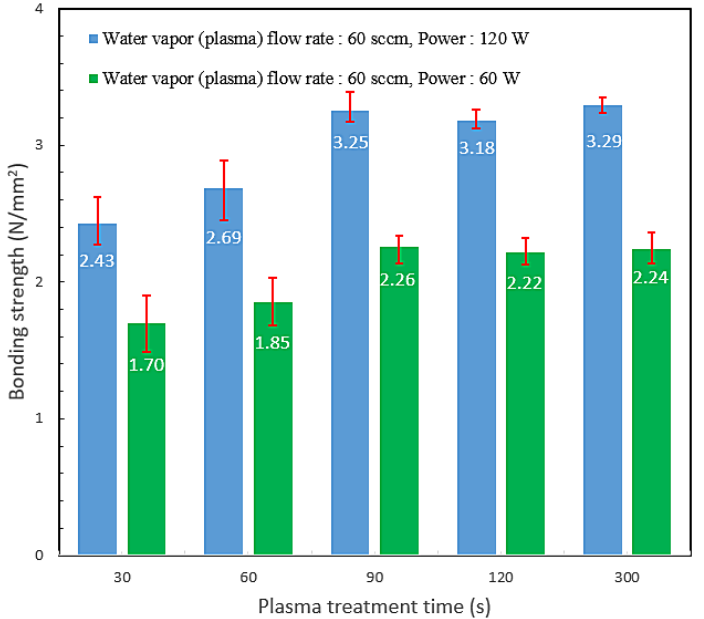
Figure 7. Bond strength of sample substrates with the standard deviation after H 2 O plasma treatment showing dependence of the bond strength on plasma treatment time: 30 s to 300 s (gas flow rate: 60 sccm; maximum bond strength: 3.29 N/mm 2 ). The order is as follows: 2.43, 2.69, 3.25, 3.18 N/mm 2 for a 60 W plasma treatment for 1.70, 1.85, 2.26, 2.22, and 2.24 N/mm 2 .